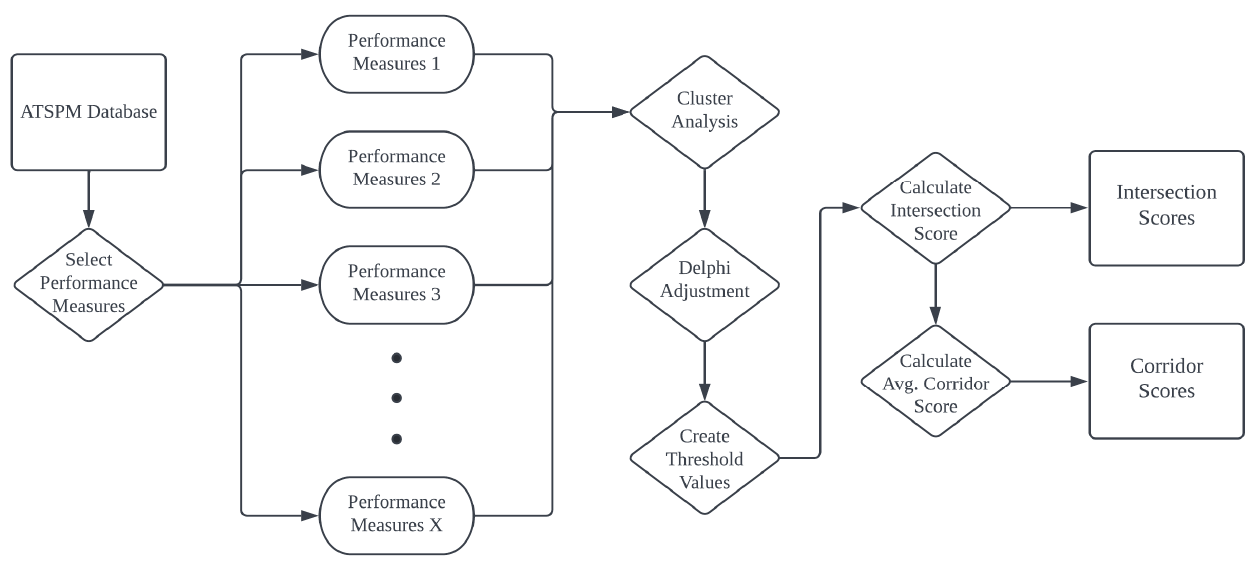
Figure 1. Threshold development and score evaluation workflow.